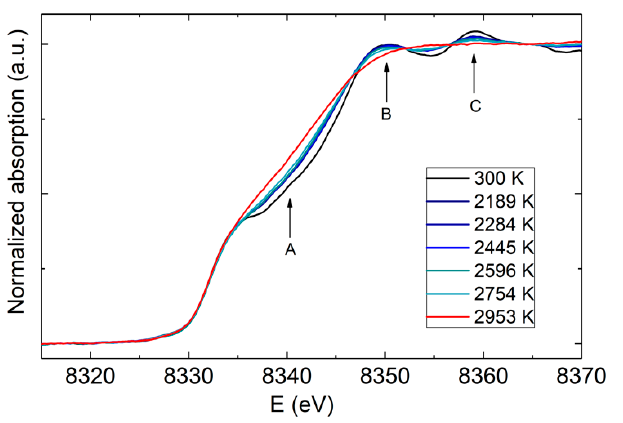
Figure 5. X-ray absorption near edge structure (XANES) spectra for Ni at different temperatures (reproduced from [39]). The melting can be determined by the disappearance of the shoulder in point A and the flattening of the first few oscillations (points B and C).